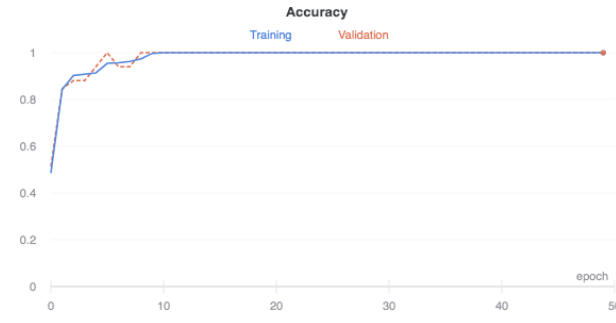
Figure 5. The accuracy of TeaNet during training and validation.